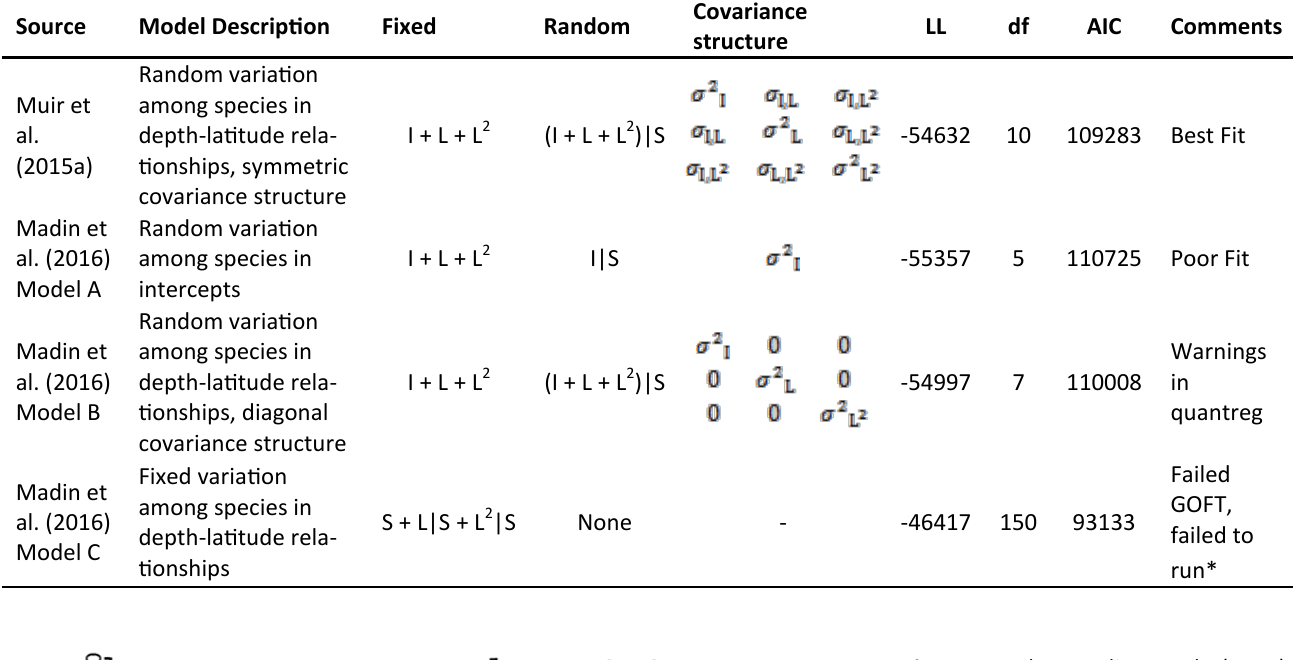
Figure 1. The Madin et al. (2016) analysis (fixed effects polynomial